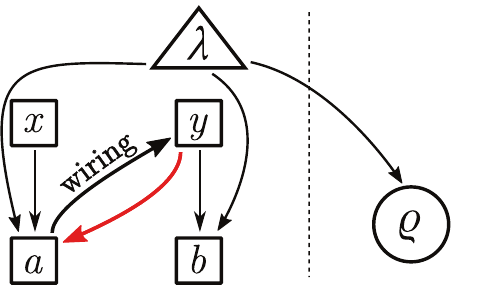
Fig. 2 Steering exposure as a causal loop. In the causal network underlying LHS models, given by Eq. (4), the hidden variable λ directly in fl uences Charlie ’ s quantum state ϱ as well as the Alice and Bob ’ s outputs a and b , which are in turn also in fl uenced by the inputs x and y , respectively. Even though the observed assemblage (after averaging λ out) is non-signaling, the model can still exploit hidden signaling (i.e., at the level of λ ). For instance, for each λ , Alice ’ s output may depend (red arrow) on Bob ’ s input in a different fi ne- tuned way such that the dependence vanishes at the observable level. The wiring of Fig. 1b forces y = a , closing a causal loop that will in general con fl ict with the latter dependence for some λ . As a consequence, the fi nal assemblage resulting from the wiring may not admit a valid LHS decomposition, exposing steering. Hence, the exposure can in a sense be thought of as an operational benchmark for hidden signaling in the LHS model describing the initial